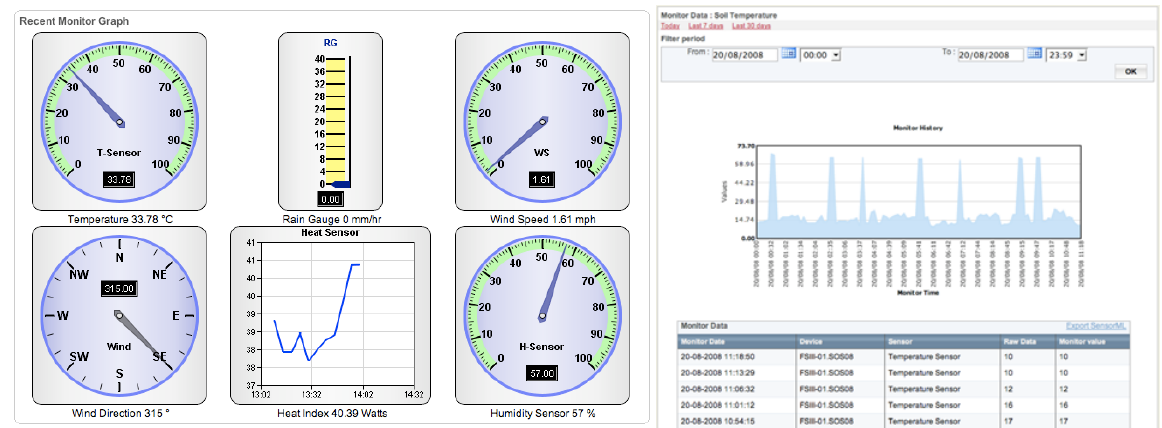
Figure 6. Data viewed in simple graphs and